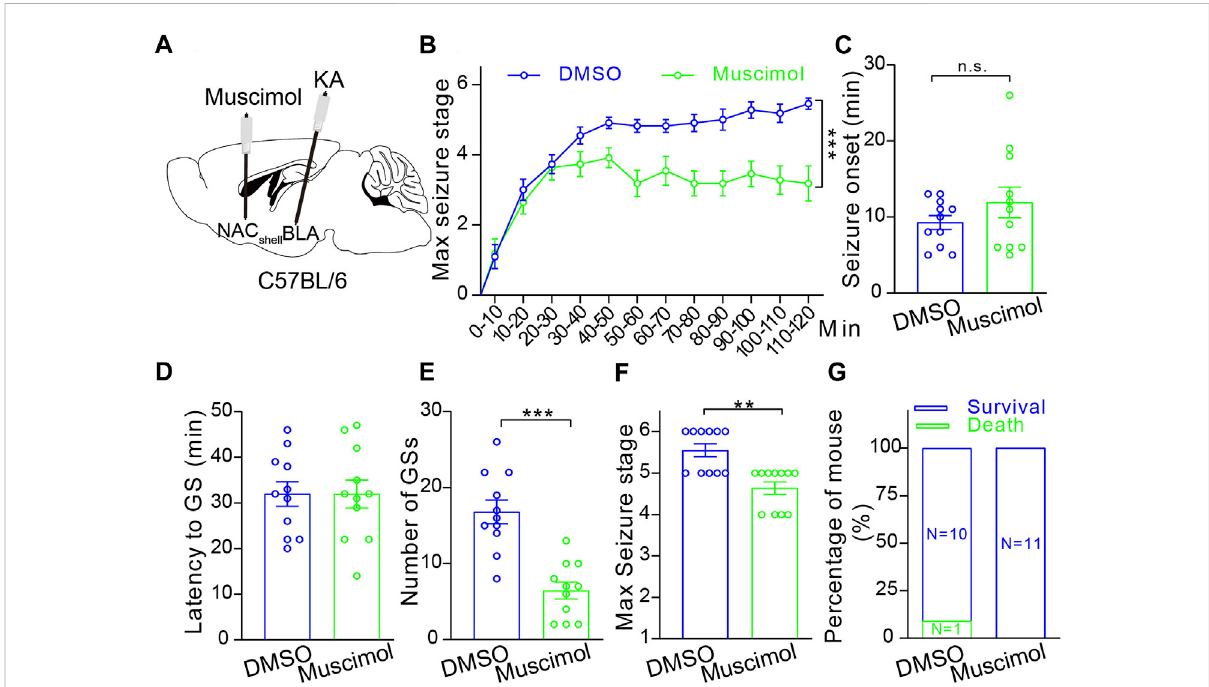
FIGURE 5 Pharmacological inhibition of the NAc shell alleviates TLE seizures. (A) Schematic diagram of muscimol microinjection to inhibit the NAc shell and10 minlaterKAmicroinjectionintoBLAtoinduceTLEseizuresoftheC57BL/6mouse. (B) Racine ’ sscalingofthemicetreatedwithDMSOcontrol ( n =11mice)ormuscimol( n =11mice),showingthemaximalseizurestageevery10 minduringthewholecourseof120 minafterKAmicroinjection. *** p < 0.001, two-way ANOVA with repeated-measures. (C) The onset time of the fi rst seizure after KA microinjection. DMSO control: n = 11 mice; muscimol n = 11 mice; Student ’ s unpaired t-test. (D) Latency to secondarily general seizures (GSs) after KA microinjection. DMSO control: n =11mice;muscimol n =11mice;Student ’ sunpairedt-test. (E) TotalnumberofsecondarilyGSsafterKAmicroinjection.DMSOcontrol: n =11mice; muscimol n = 11 mice; *** p < 0.001, Student ’ s unpaired t-test. (F) Maximal seizure stage in the whole course of 120 min after KA microinjection. DMSO control: n = 11 mice; muscimol n = 11 mice; ** p < 0.01, Mann – Whitney rank sum Test. (G) Mortality rate after KA microinjection. DMSO control: n = 11 mice; muscimol n = 11 mice; chi-square